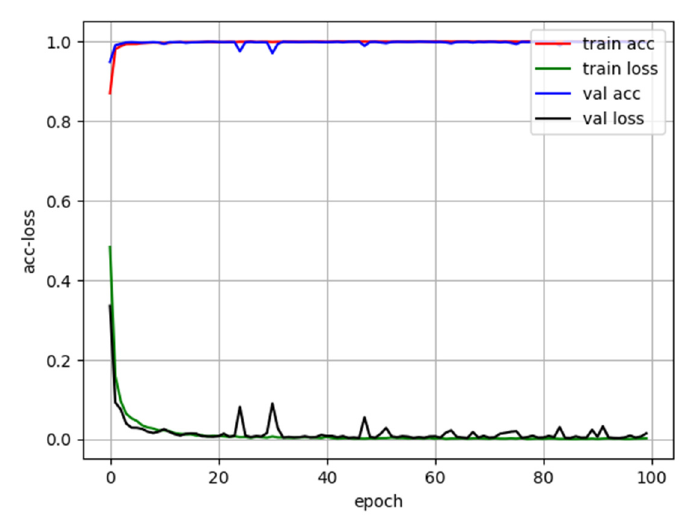
Figure 13. Evaluation of emergency rescue recognition DNN model.